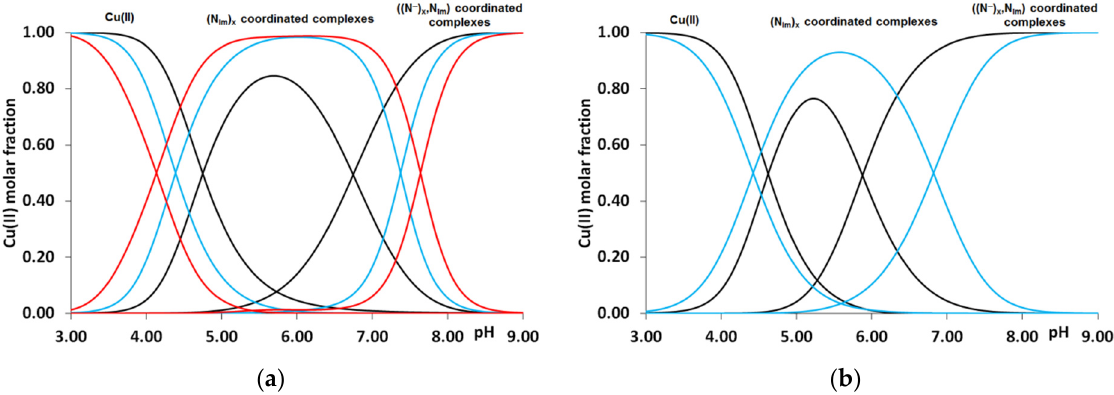
Figure 2. Distribution of imidazole- and amide nitrogen-coordinated complexes formed in equimo- lar solution of Cu(II)-Ac-HADH-NH 2 ( ■ ), Cu(II)-Ac-HADHAH-NH 2 ( ■ ) and Cu(II)-Ac- HDHAHDH-NH 2 ( ■ ) ( a ). Cu(II)-Ac-HFHAH-NH 2 ( ■ ) and Cu(II)-Ac-HDHAH-NH 2 ( ■ ) (c L = c M = 2 NH 2 ( (cid:4) ) ( a ). Cu(II)-Ac-HFHAH-NH 2 ( (cid:4) ) and Cu(II)-Ac-HDHAH-NH 2 ( (cid:4) ) (c L = c M = 2 mM) ( b ). mM) ( b ).